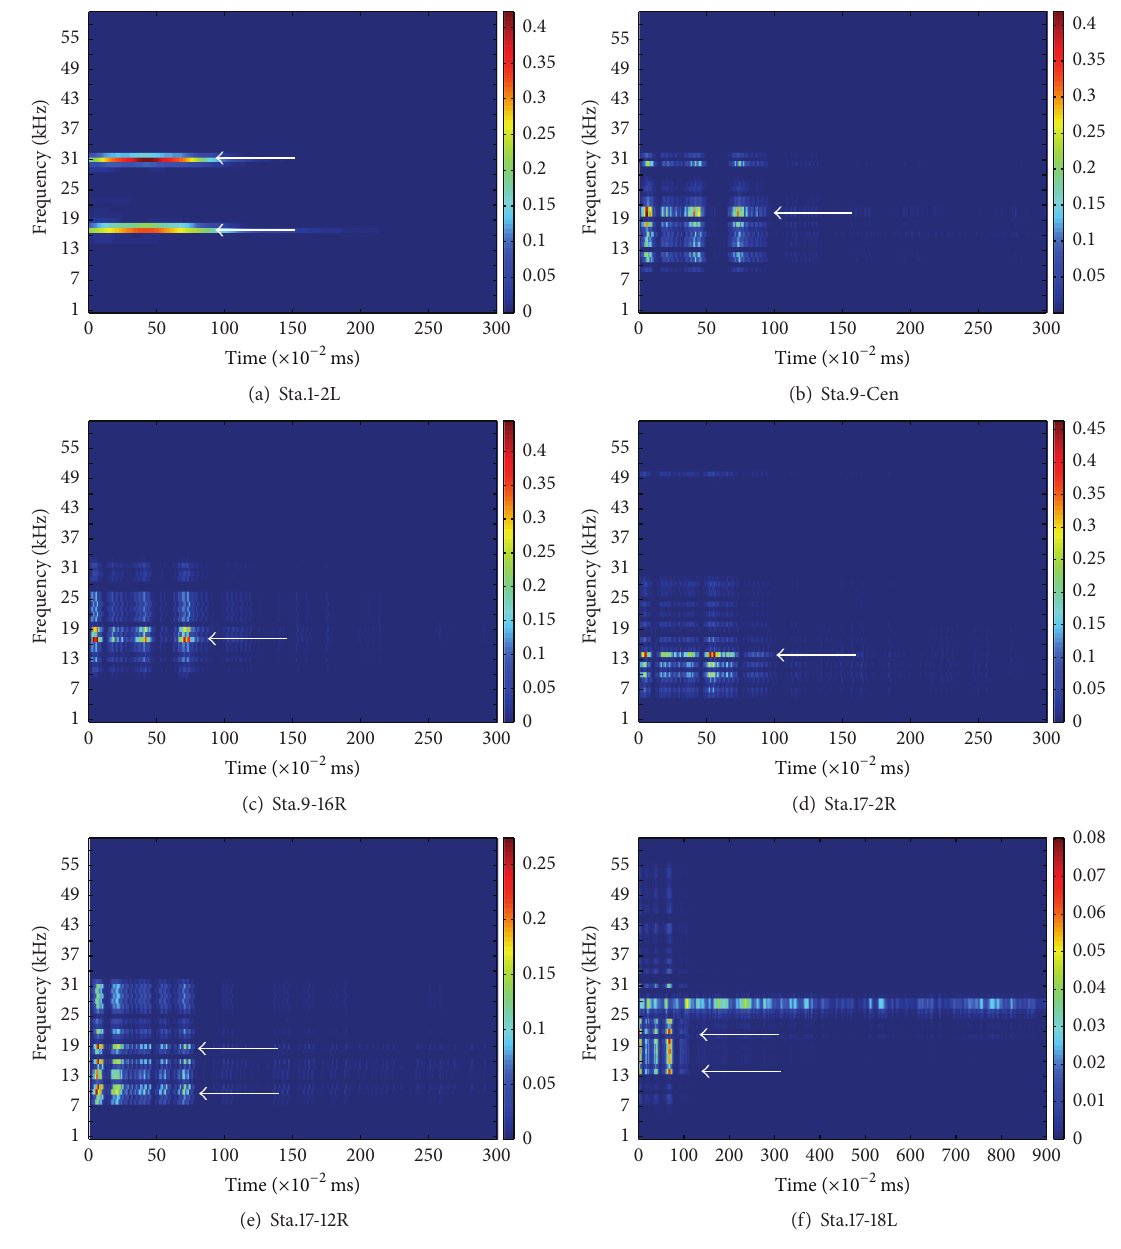
Figure 6: Scalograms at different test